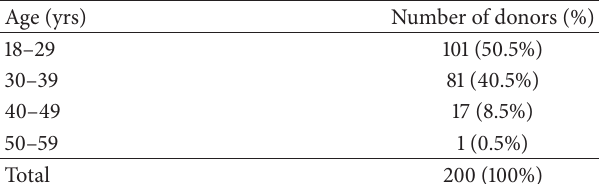
Table 4: Number of donors as stratified by age (years).